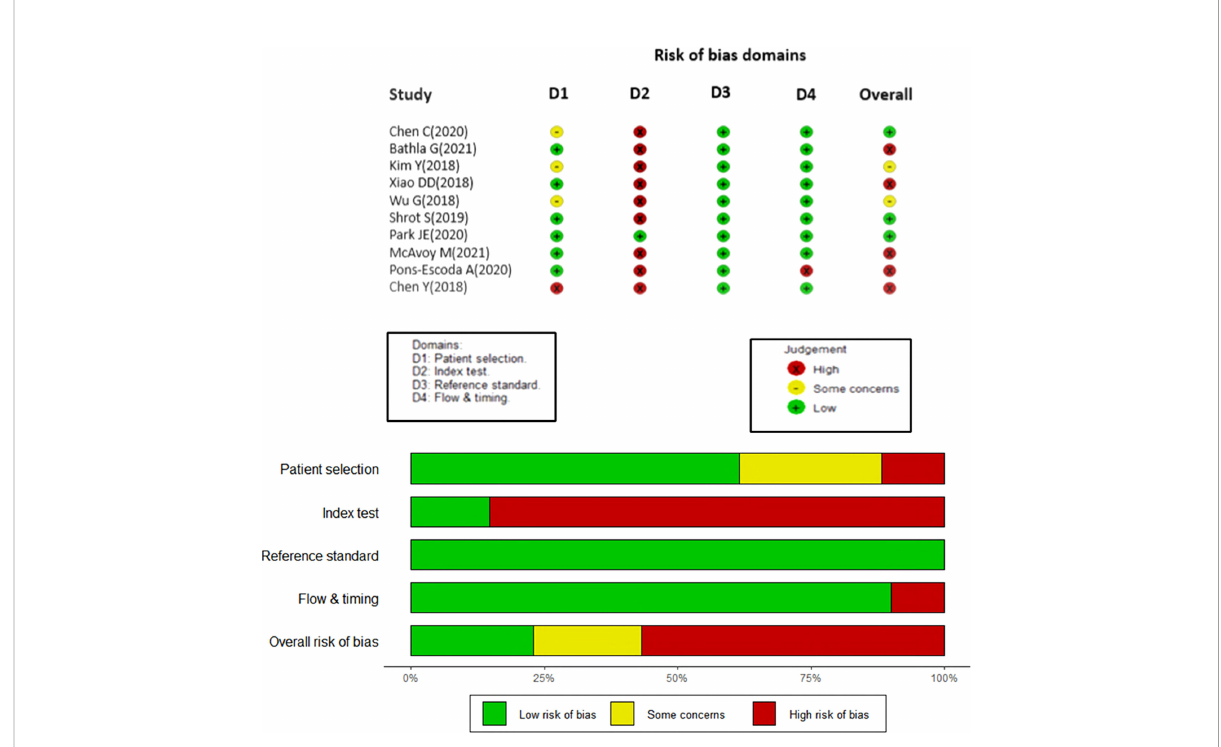
FIGURE 2 Studies included in the meta-analysis with the quality of diagnostic accuracy studies (QUADAS)